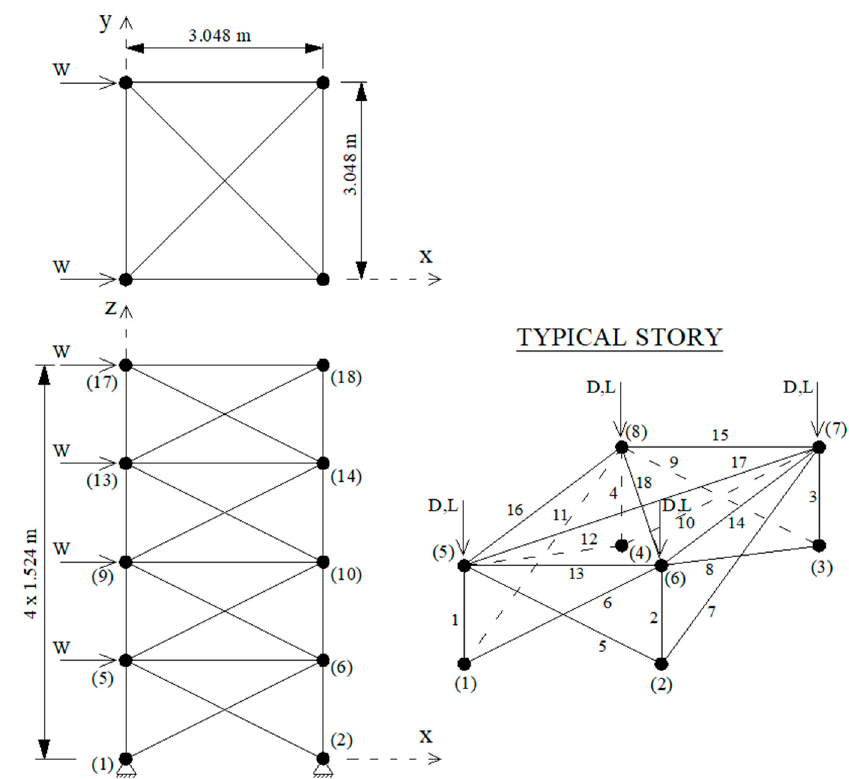
Figure 8. Layout and geometry of the 72-bar truss.